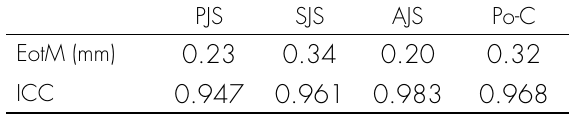
Table II. Error of the method (EotM) and intraclass correlation